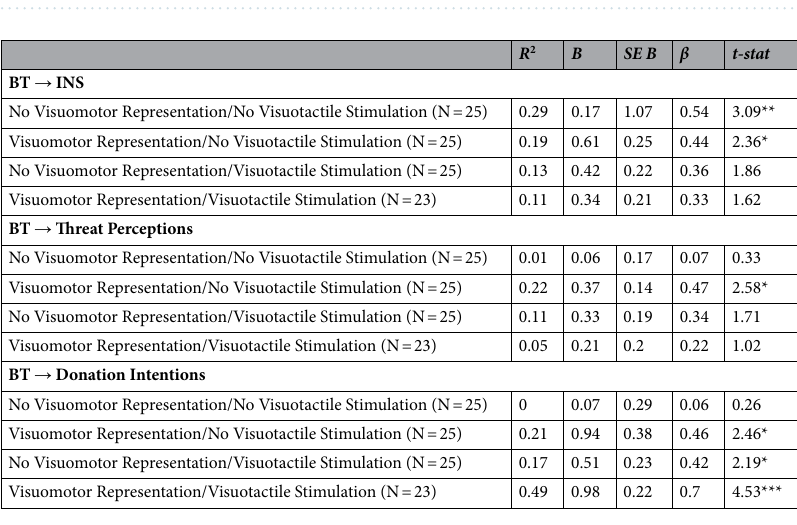
Table 2. Linear regression analyses of body transfer on key dependent variables in Study 2 across experimental conditions. * P < 0.05, ** P < 0.01, *** P < 0.001.